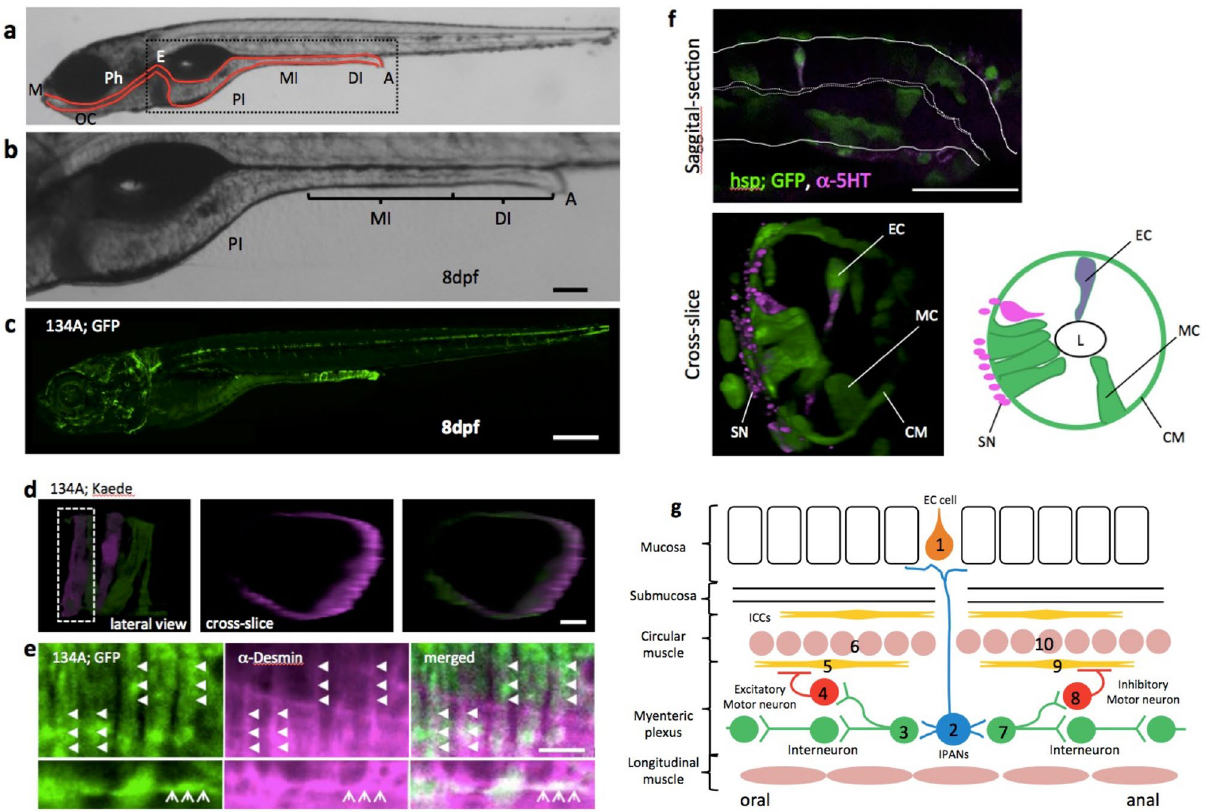
Figure 1. Simple structure of the zebrafish gut. ( a ) Lateral view of zebrafish larva at 8 dpf, indicating the principal digestive tract. The intestine is divided into three parts: proximal intestine (PI), middle intestine (MI), and the distal part of the intestine (DI) 10 . The PI is also referred to as the intestinal bulb and is thought to have similar functions as the stomach, which zebrafish do not have. The MI is thought to absorb nutrients and plays a role in mucosal immunity. The DI is analogous to the colon. M mouth, OC oral cavity, Ph pharynx, E esophagus, PI proximal intestine, MI middle intestine, DI distal intestine, A anus. ( b ) A higher-magnification image of the area indicated by the square in ( a ). Scale bar, 50 μm. ( c ) Lateral view of SAGFF(LF)134A; Tg(UAS: GFP) at 8 dpf. Scale bar, 200 μm. ( d ) Live confocal image of individual circular smooth muscles visualized by green to red photoconversion of Kaede fluorescence in SAGFF(LF)134A; Tg(UAS: Kaede) at 5 dpf. Lateral projection view shows two muscles photoconverted. Left side view. Cross-slice view of the dotted area shows a single red muscle. Scale bar, 10 μm. ( e ) Saggital sections of a confocal image of SAGFF(LF)134A; Tg(UAS: GFP) at 8 dpf stained with anti-Desmin antibody. Upper panels demonstrate Desmin filaments (in magenta, shown by triangles) located inside of each circular smooth muscles expressing GFP. Lower panels show an example of occasional appearance of longitudinal muscle cell expressing GFP, containing Desmin filaments (arrows). Scale bar, 10 μm. ( f ) Saggital section and cross-slice of the gut, indicating a variety of cell types visualized at 5 dpf in Tg(hsp70: Gal4); Tg(UAS: GFP) by heat shock at 3 dpf. Double immunostaining for anti-GFP (green) and anti-5-HT (magenta). EC serotonergic endochromaffin cells, MC mucosal cells, L lumen, CM circular muscle, SN neurites of serotonergic neurons. Scale bar, 50 μm. ( g ) Schematic diagram showing the hypothetical circuitry for the peristaltic reflex in the zebrafish gut. 1, endochromaffin cell; 2, intrinsic primary afferent cell; 3, ascending interneuron; 4, excitatory motoneuron; 5, 9, interstitial cells of Cajal; 6, 10, circular smooth muscles; 7, descending interneuron; 8, inhibitory